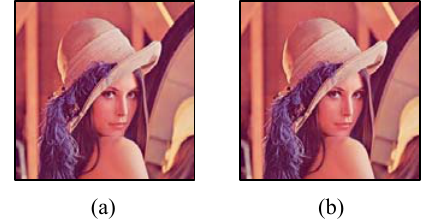
Fig. 9. Comparison with the secret image and the revealed image of size 256×256 pixels. (a) The secret image S , (b) The revealed image